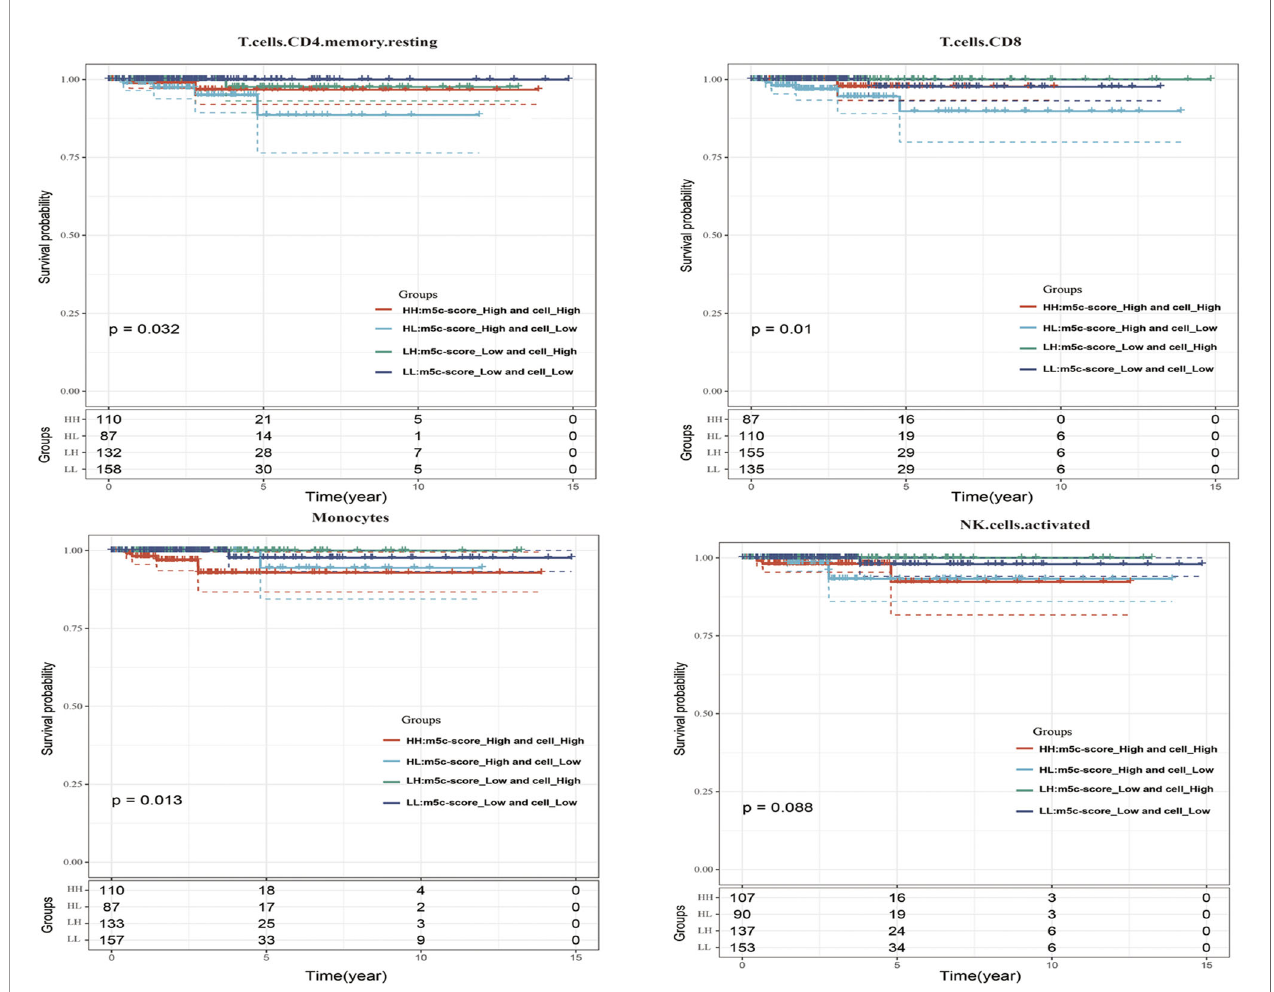
FIGURE 6 | The in fl uences of the m 5 C-score and various immunocyte (resting CD4 + memory T cells, CD8 + T cells, activated NK cells, and monocytes) in fi ltration levels on the prognosis for PTC